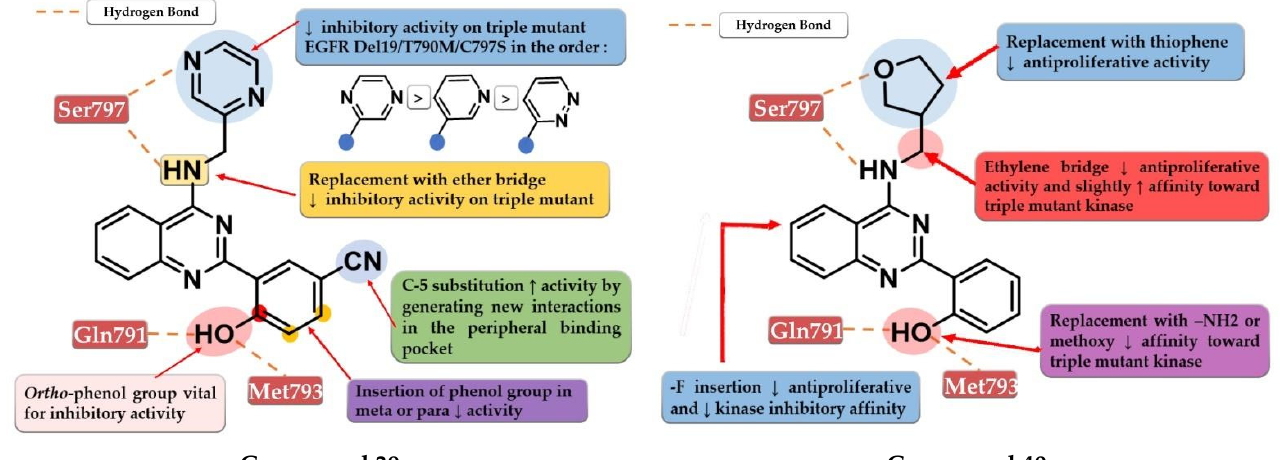
Figure 28. Structure–activity relationship and molecular docking of compound 39 in the EGFR del19/T790M/C797S kinase domain, constructed by homology using EGFR L858R/T790M (PDB ID 3W2R) [209], as reported by Park et al. [208]; structure–activity relationship and molecular docking of compound 40 in the human EGFR T790M/C797S kinase domain (PDB ID 5XGN) [210], as reported by Zhou et al. [207].